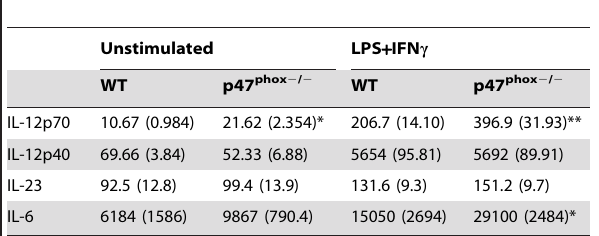
Table 1. IFN c /LPS induced DC cytokine secretion.